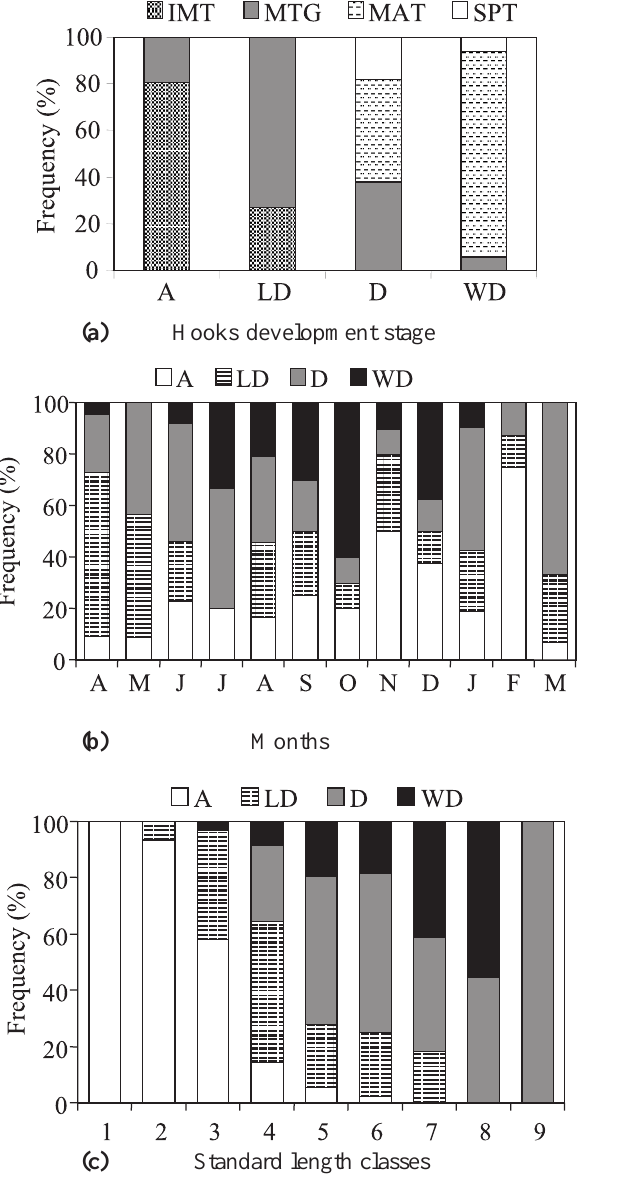
Fig. 4. Frequency of occurrence of hooks (a) by gonadal maturation stages; (b) by month and (c) by standard length classes in males of Bryconamericus iheringii from rio Vacacaí, RS, Brazil, from April/2001 through March/ 2002. IMT = immature; MTG = maturing; MAT = mature; SPT = spent; A= absent; LD= less developed; D= developed; WD= well